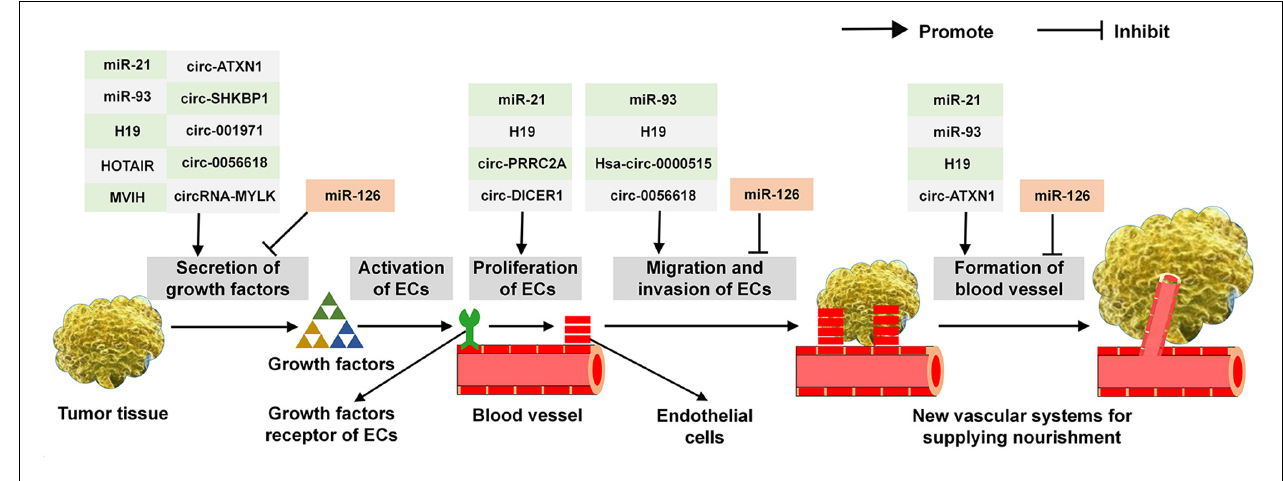
FIGURE 3 | The functions of common ncRNAs on regulating the critical step in tumor